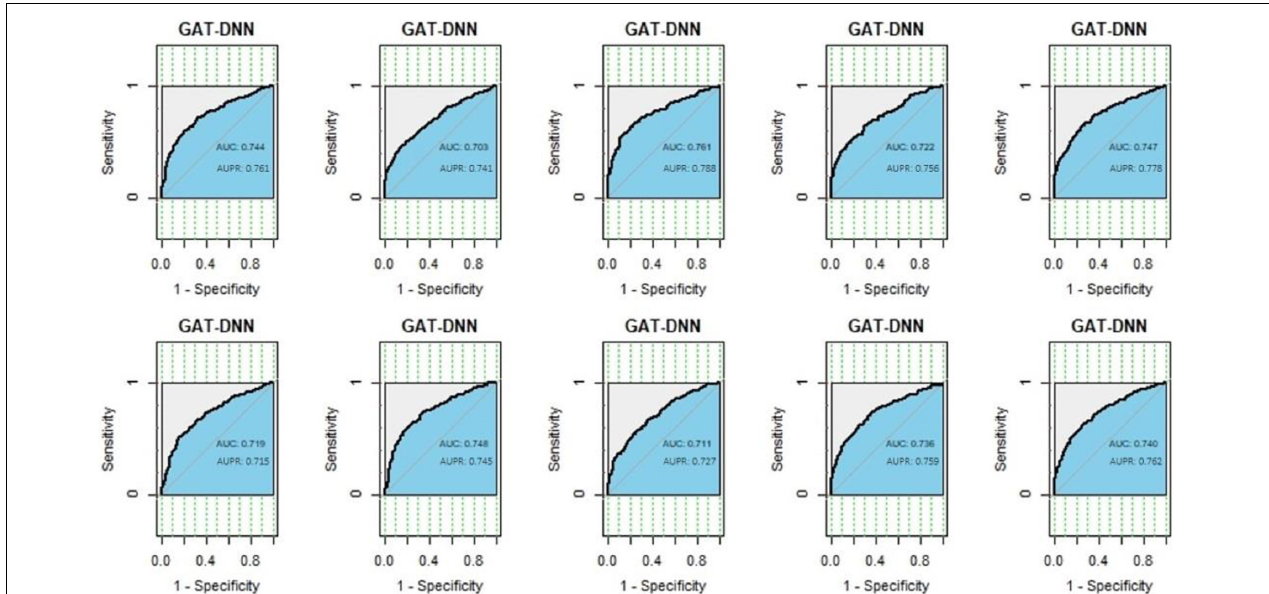
FIGURE 2 | The performance of graph attention network-deep neural network (GAT-DNN) across a 10-fold